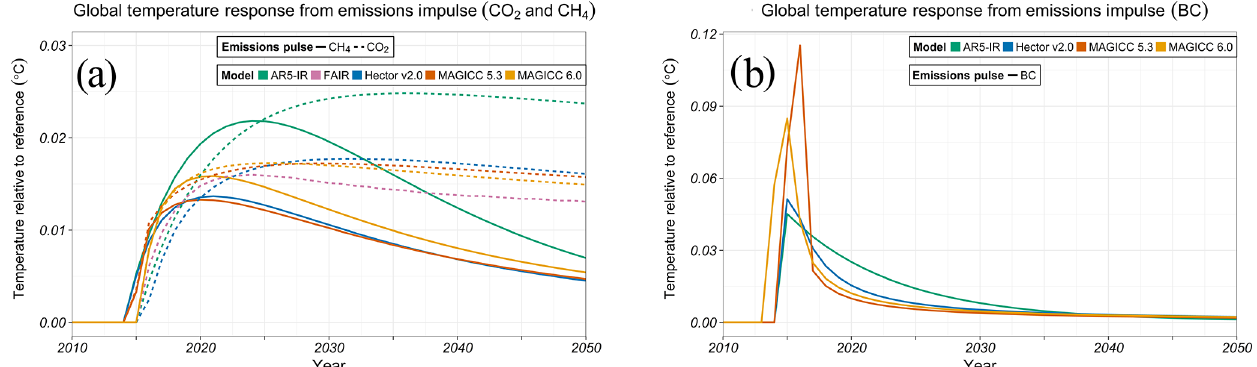
Figure 3. Global mean temperature response from CO 2 and CH 4 emissions perturbations (a) and BC emissions perturbation (b) in SCMs (MAGICC 6.0 – yellow, MAGICC 5.3 BC–OC – red, Hector v2.0 – blue, AR5-IR – green, FAIR –